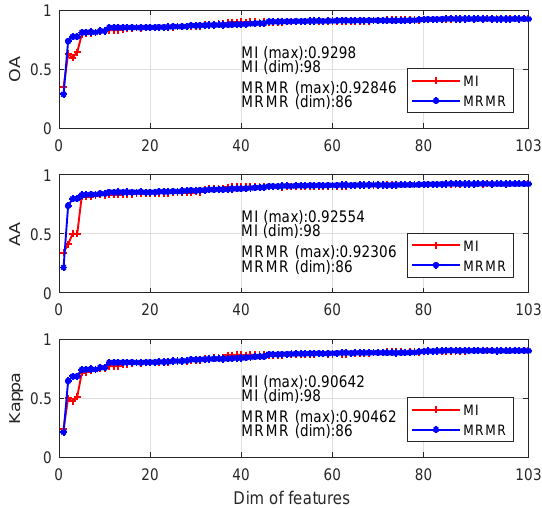
Figure 10. Comparative results betweenMI and MRMR: MI (red+ line); MRMR (blue*